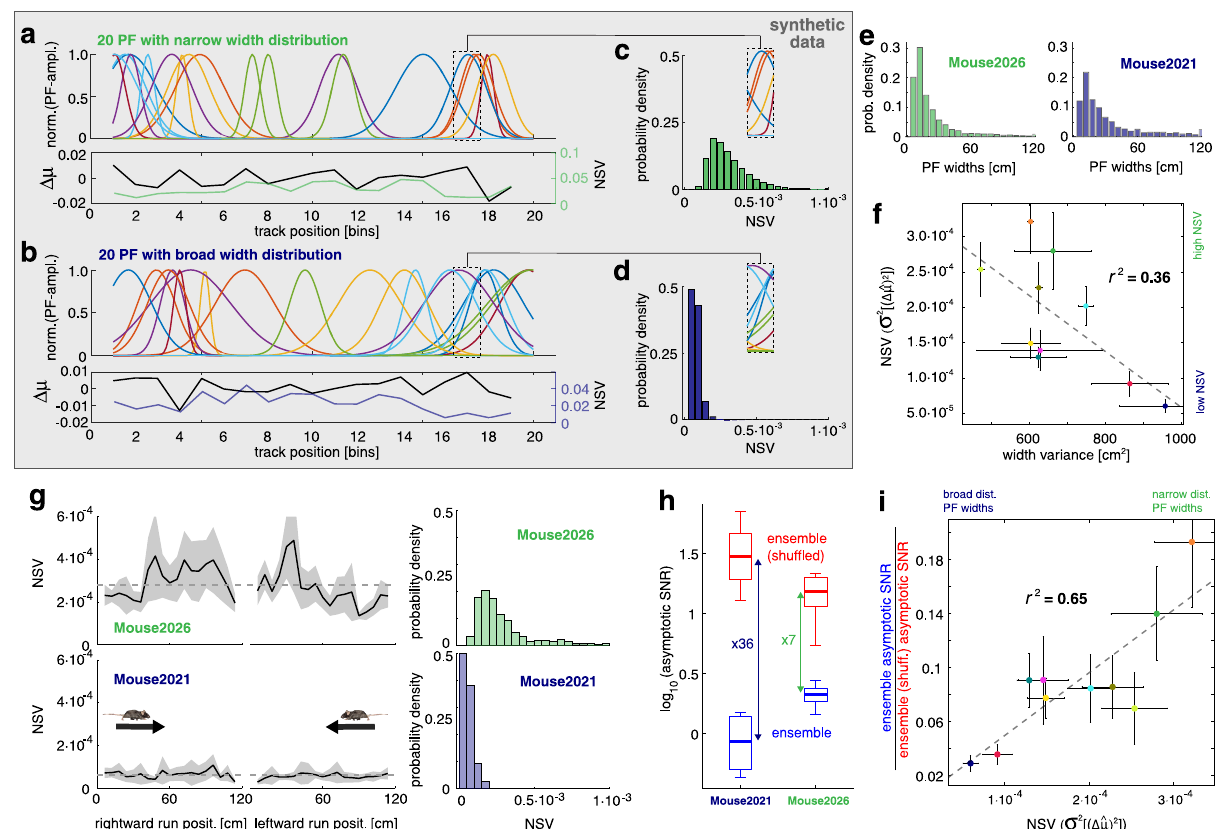
Fig. 5 PF shape heterogeneity explains the effect size of noise correlations on decreasing spatial representation accuracy. a Top: Synthetic distribution of narrow PFs generated by 50 Gaussian curves with a uniform width distribution of min = 0.2 and max = 1.42. Bottom: Average over the distribution of synthetic PF slopes within each spatial bin (black), and the variance of the normalized PF slope distribution, called normalized signal variance ð NSV ¼ σ 2 ½ð ^ Δ μ Þ 2 (cid:3)Þ , between two spatial bins (red). b Same as in (a), but with a uniform width distribution of min = 0.8 and max = 2.0. The distributions were chosen from a parameter study to match our recorded data (Suppl. Fig. 16). c Distribution of NSV from each bin, generated from 1000 simulations of the PFs in a . d Distribution of NSV from each bin, generated from 1000 simulations of the PFs in b . The variance of the PFs determines the shape of the PF slope distribution (inset rectangles, top-right). e Width distributions for two example animals: 2026 (narrow distribution) and 2021 (broad distribution). f Correlation between animal ’ s PF width and NSV. The broader the width distribution, the narrower the NSV values per animal. Pearson ’ s corr. = − 0.65, r 2 = 0.36, p val = 0.039. Each dot represents the average over sessions for each animal. Error bars are the 95% con fi dence intervals over sessions. g NSV for each bin from the linear track for one session. Two extreme example animals: high NSV (Top: Mouse2026), low NSV (Bottom: Mouse2021). The dashed line represents NSV averaged over bins. Black lines and shaded areas correspond to the mean and the 95% con fi dence intervals over sessions. NSV distribution for all bins, from all mouse sessions (Left). h Asymptotic SNR changes after eliminating noise correlations (shuf fl e). The effect is higher in animals with a small NSV. Each thick line represents the median over sessions for each animal. Boxes top and bottom edges represent the interquartile range (IQR). Whiskers minima is the ( fi rst quartile)-1.5*IQR and the maxima is the (third quartile) + 1.5*IQR. i Correlation between the asymptotic SNR ratio (i.e., ensemble with noise correlations over ensemble shuf fl ed) and averaged NSV (Pearson ’ s corr. = 0.83, r 2 = 0.65, p val = 0.003). Each dot represents the average over sessions for each animal. Error bars are the 95% con fi dence intervals over sessions. Animals whose neuronal representation had a narrow PF width distribution were more affected by noise correlations. Source data is provided as a Source Data fi